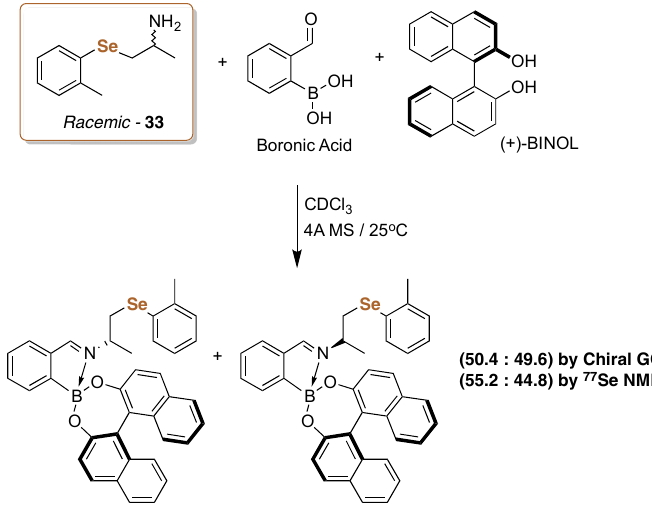
Scheme 28. Three-component reaction for chiral discrimination of selenide amines by 77 Se { 1 H} NMR spectroscopy.